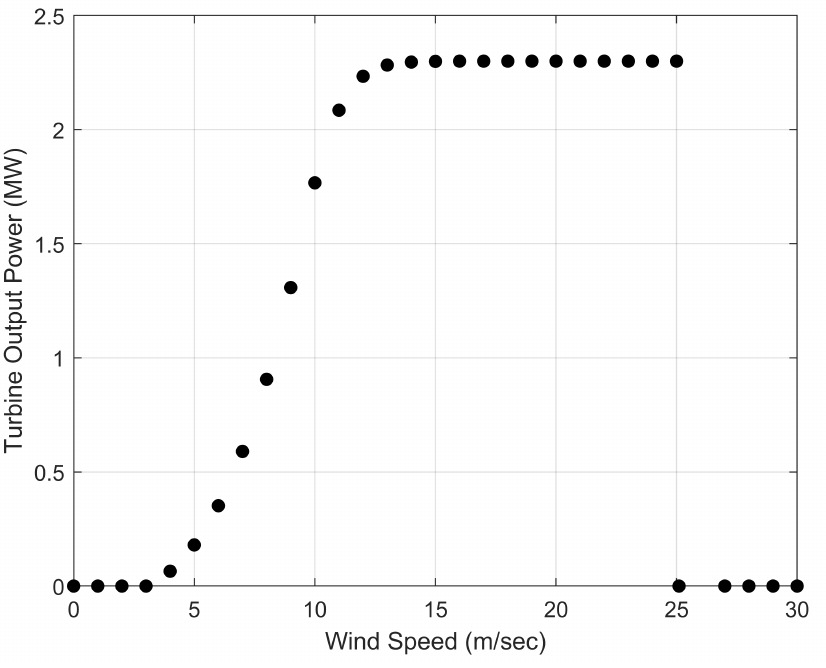
Figure 3. Power curve of SWT-2.3-93 turbine [2].